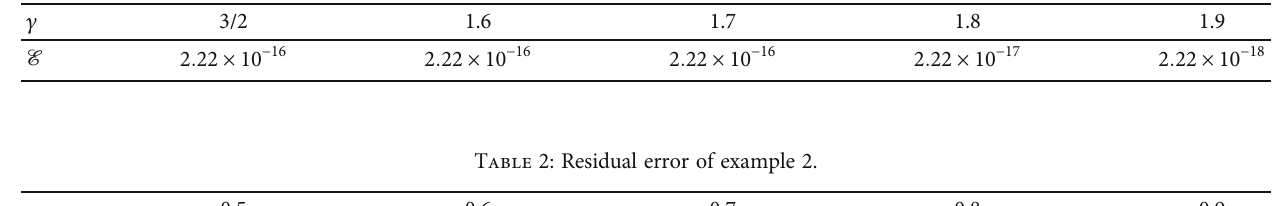
Table 1: Residual error of example 1.